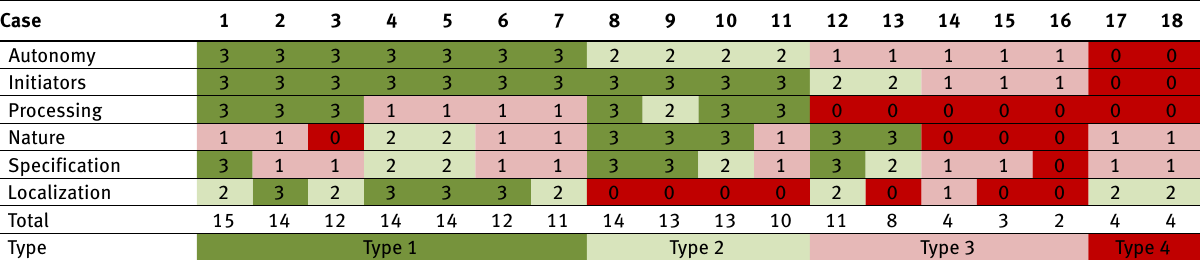
Table 2: The Bertin graphic analysis of the 18 initiatives